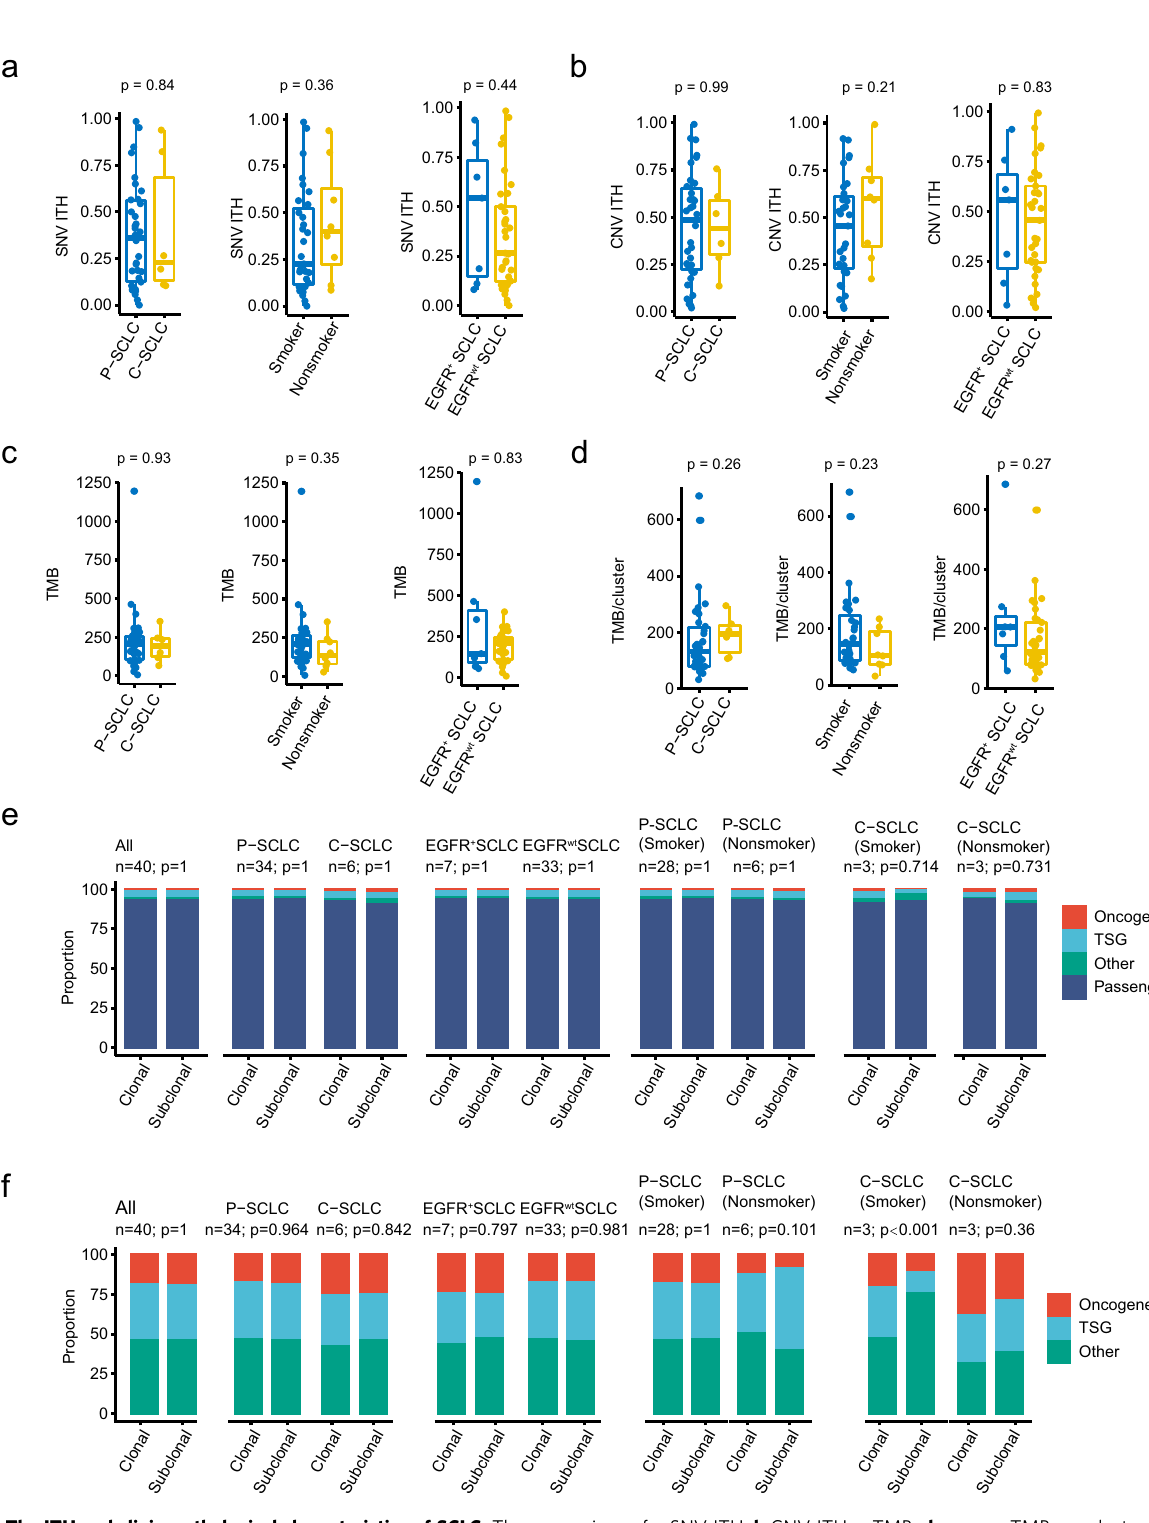
Fig. 4 The ITH and clinicopathological characteristics of SCLC. The comparison of a SNV ITH, b CNV ITH, c TMB, d average TMB per cluster between pure SCLC ( n = 34) and combined lung cancer ( n = 6), EGFR mutant ( n = 7), and wild type ( n = 33), as well as smoking ( n = 31) and nonsmoking ( n = 8) subgroups. p Value from two-sided Mann – Whitney U test. Boxplots are represented by a centerline, median; box limits, the 25th and 75th percentiles; whiskers extend represent the lower and upper values within 1.5 * inter-quartile range. e , f The proportion of driver genes, passenger genes, and other genes in the trunk and branch. p Value from two-sided Fisher ’ s exact test. SNV single-nucleotide variant, CNV copy number variation, ITH intratumoral heterogeneity, P-SCLC pure small cell lung cancer, C-SCLC combined small cell lung cancer, TMB tumor mutation burden, TSG tumor suppressor